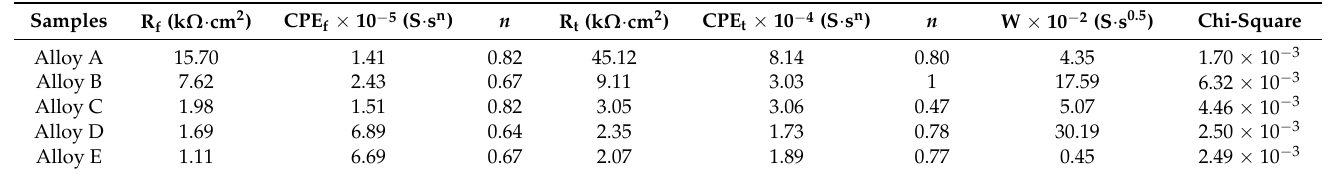
Figure 8. Electrochemical impedance spectra of the alloys A-E in 3.5 wt.% NaCl solution: ( a ) Nyquist, ( b ) Bode, ( c ) Bode, ( d ) Equivalent circuit. Table 6. The fitting results of EIS of Alloys A-E in the aerated 3.5 wt.% NaCl